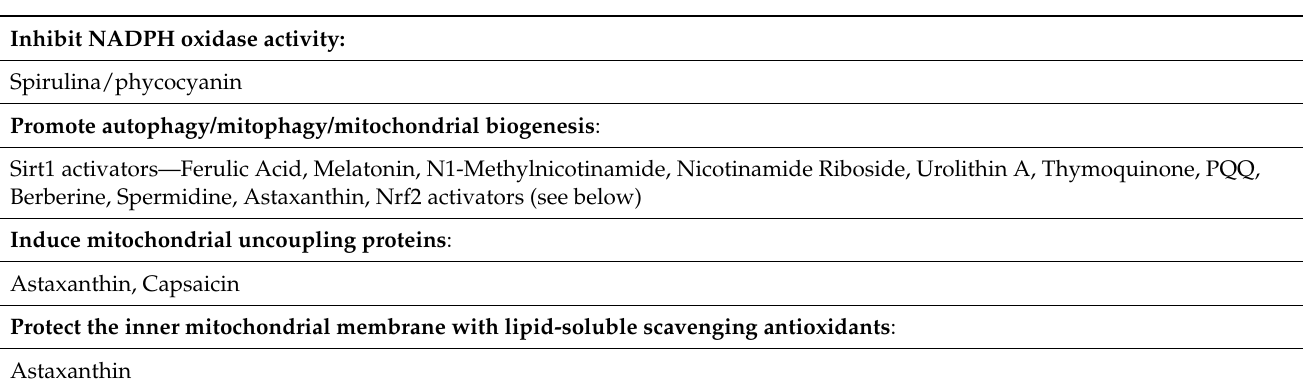
Table 1. Comprehensive Control of Oxidative and Dicarbonyl Stress with Nutraceuticals as a Strategy for Prevention of Diabetic Complications.